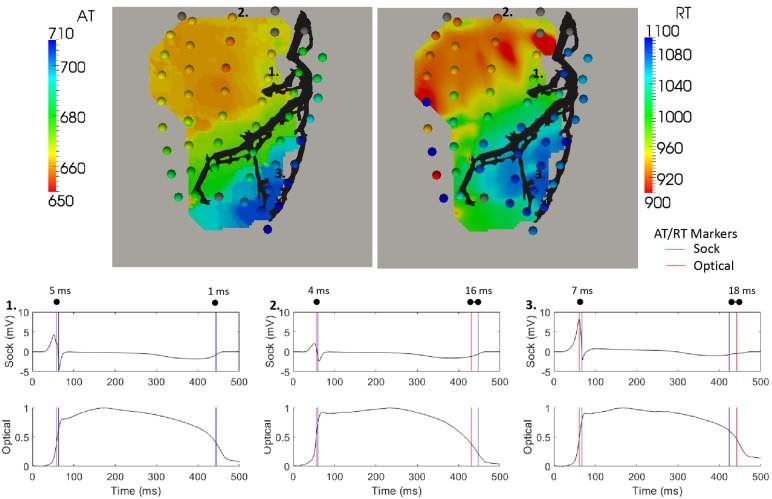
Optical activation (left) and repolarization (right) map with equivalent sock (spheres) timings overlaid during a sinus rhythm sequence with cold perfusion through the LAD (black). Sock electrograms and optical action potentials (normalized) are shown at three electrode locations demonstrating the range in differences between AT and RT markers.